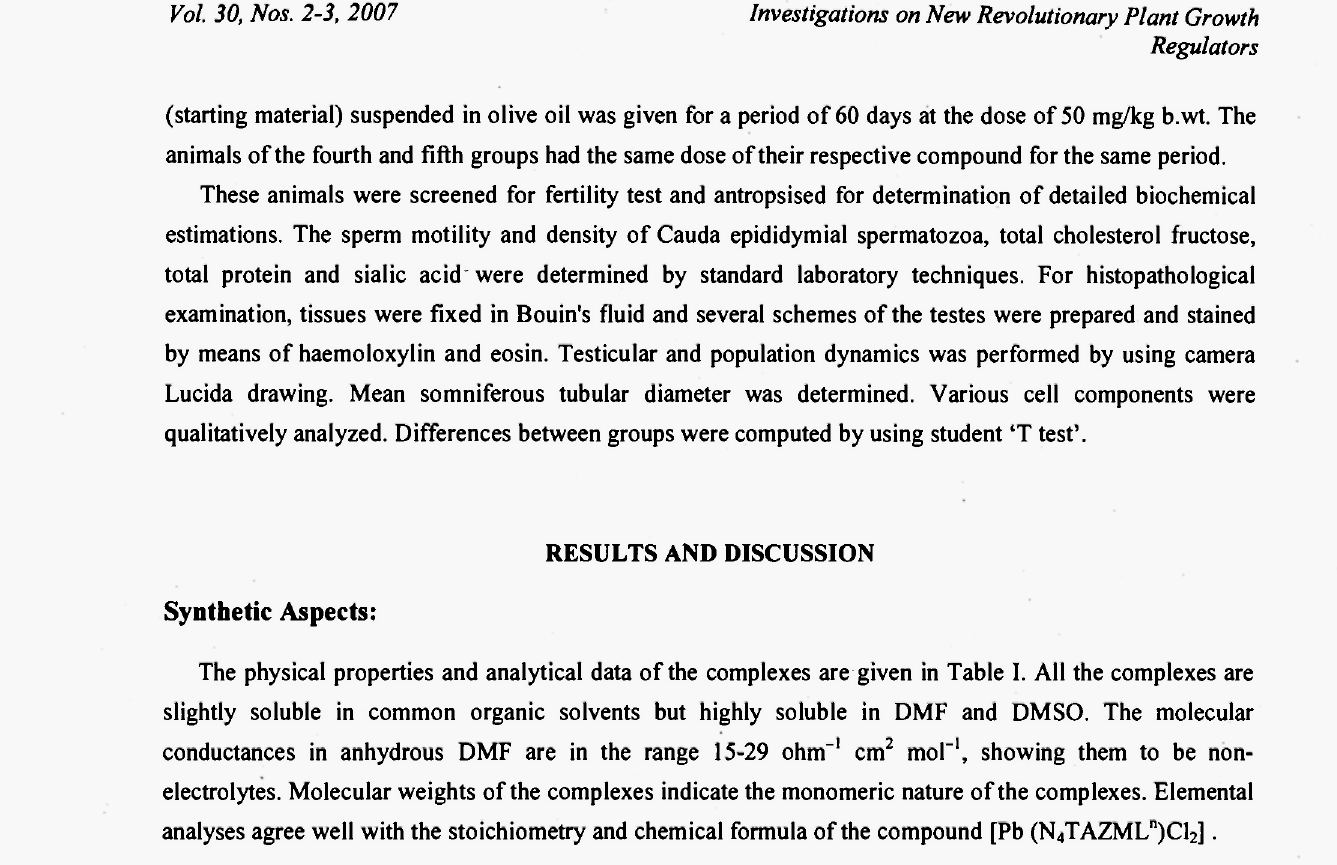
Physical Properties and Analytical Data of the Lead(II)